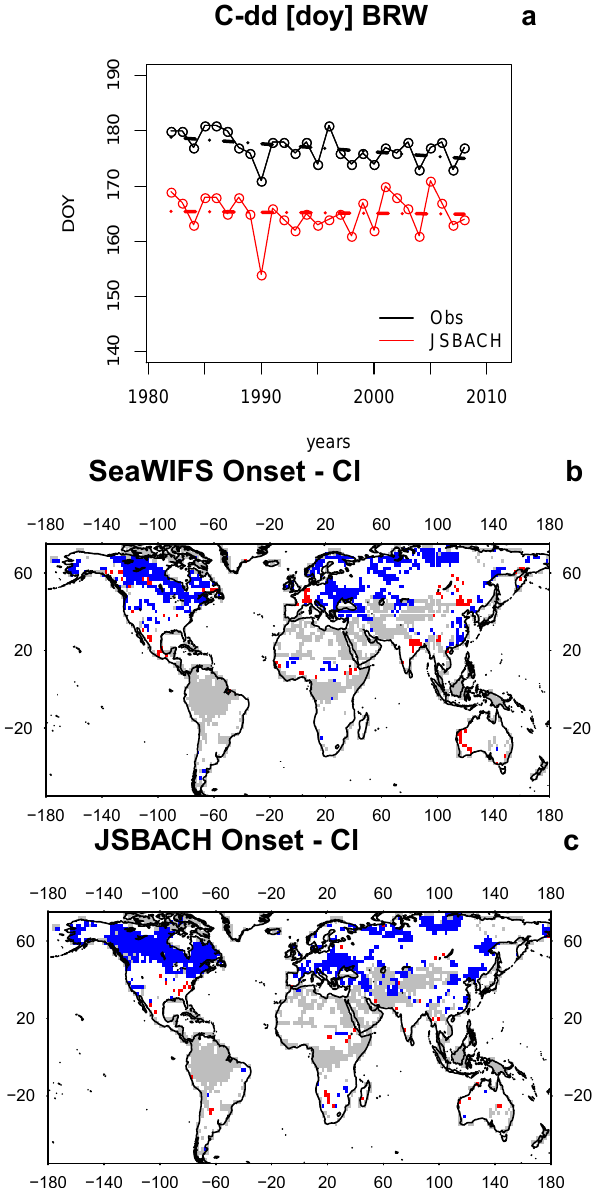
Fig. 8. (a) Atmospheric CO 2 drawdown points (C-dd) as computed at the station of Barrow (BRW) for observations and model. (b) and (c) partial correlation between time of onset and mean annual temperature computed for observations and JSBACH, for the pe- riod 1998–2005. Red: positive correlations ( P < 0 . 1); blue: nega- tive correlations ( P < 0 . 1); white: no significant correlations; grey: areas masked out from the analysis (see text).